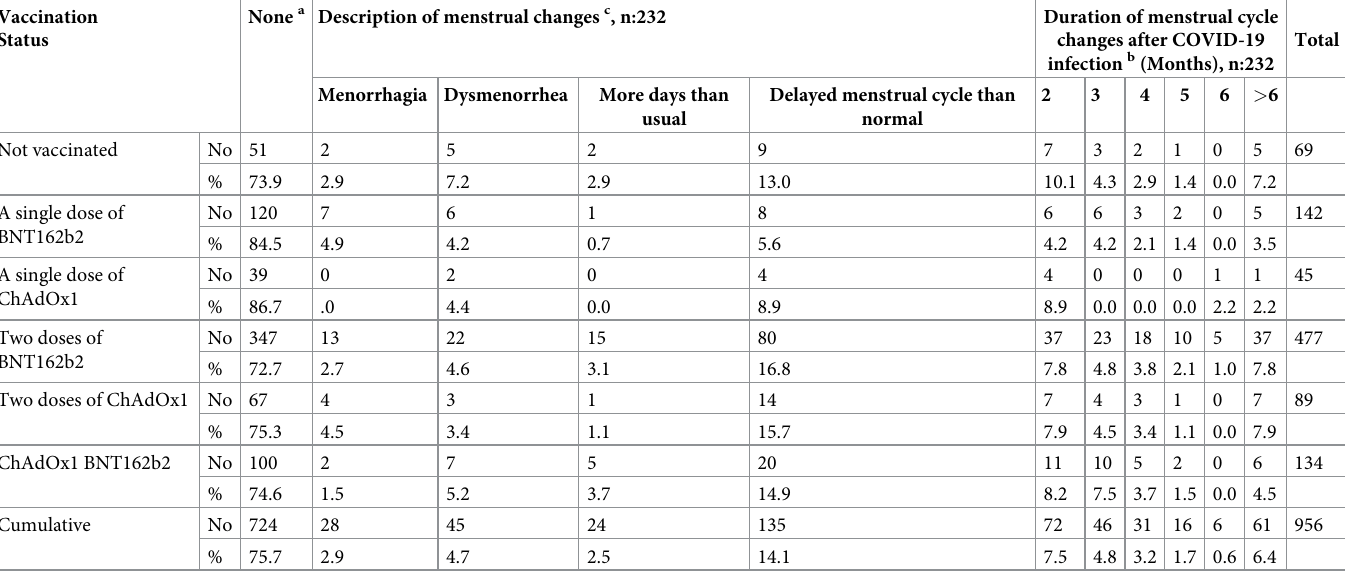
Table 2. Effect of the time of infection on the time of vaccination on the development of menstrual cycle changes following infection with SARS-CoV-2. Vaccination None a Description of menstrual changes c , n:232 Status